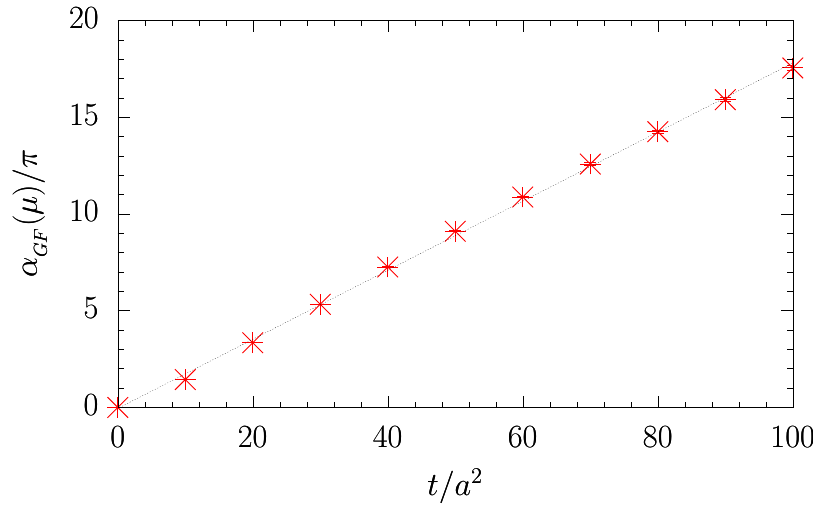
( µ ) /π on the 32 4 lattice as a function of GF